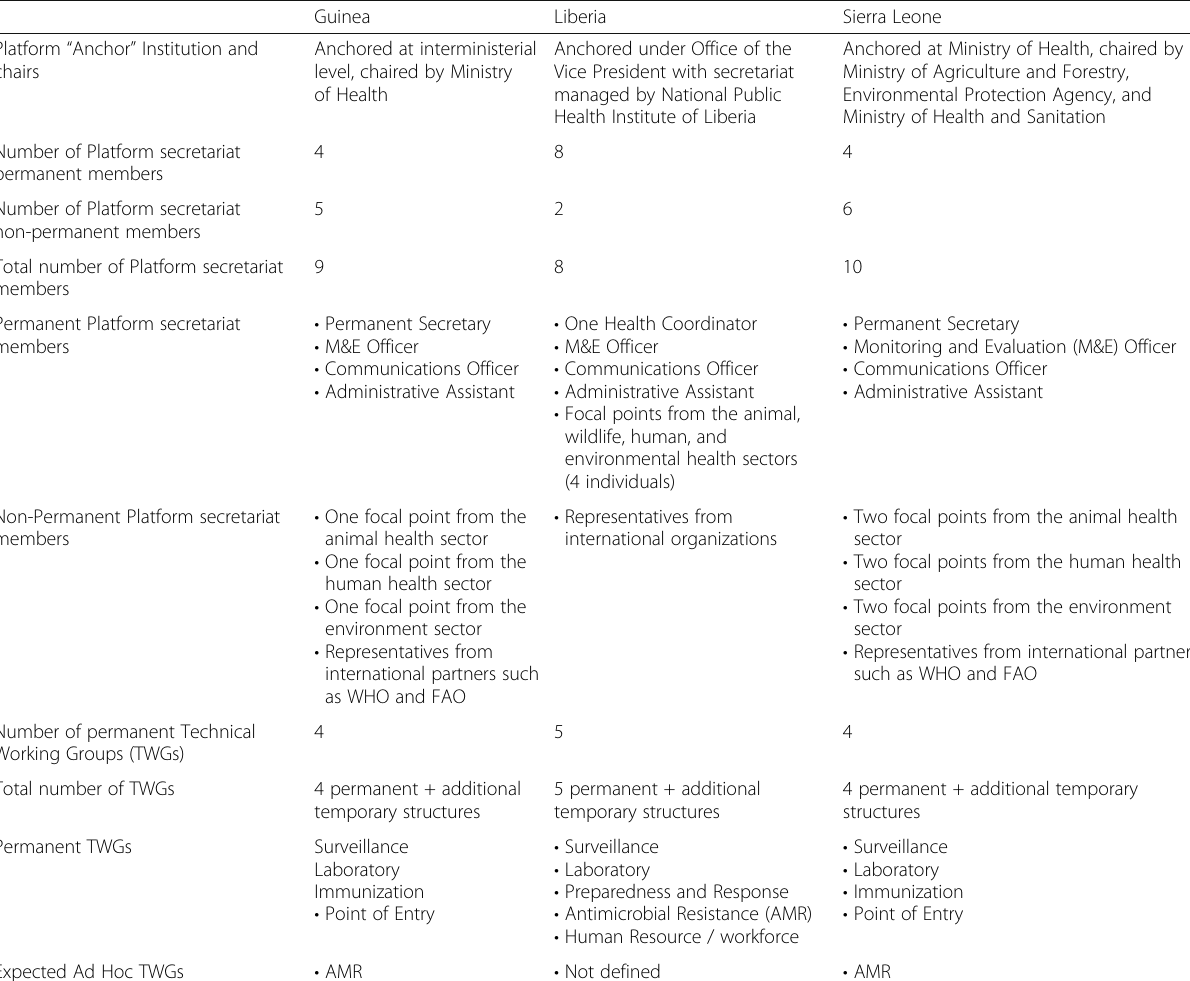
Table 2 Institutional anchorage, structure and other attributes of the National One Health Platforms of Guinea, Liberia and Sierra Leone Guinea Platform “ Anchor ” Institution and